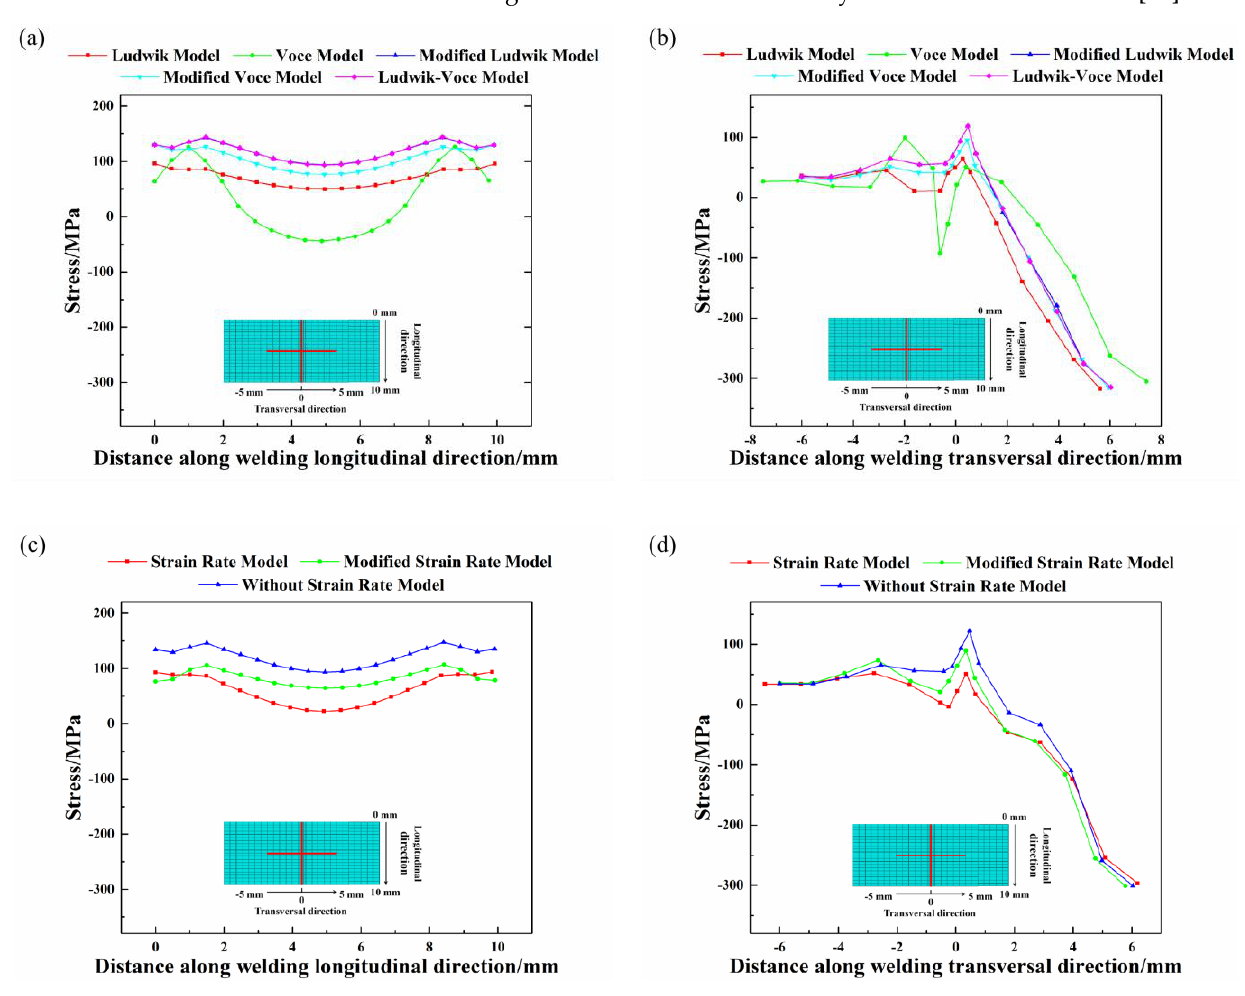
Figure 15. Low-cycle fatigue residual stress for ( a ) longitudinal for strain models, ( b ) transversal for strain models, ( c ) longitudinal for strain rate models, ( d ) transversal for strain rate models. The evolution of residual stress after 1, 2, 100 and 500 cycles is shown in Figure 16.